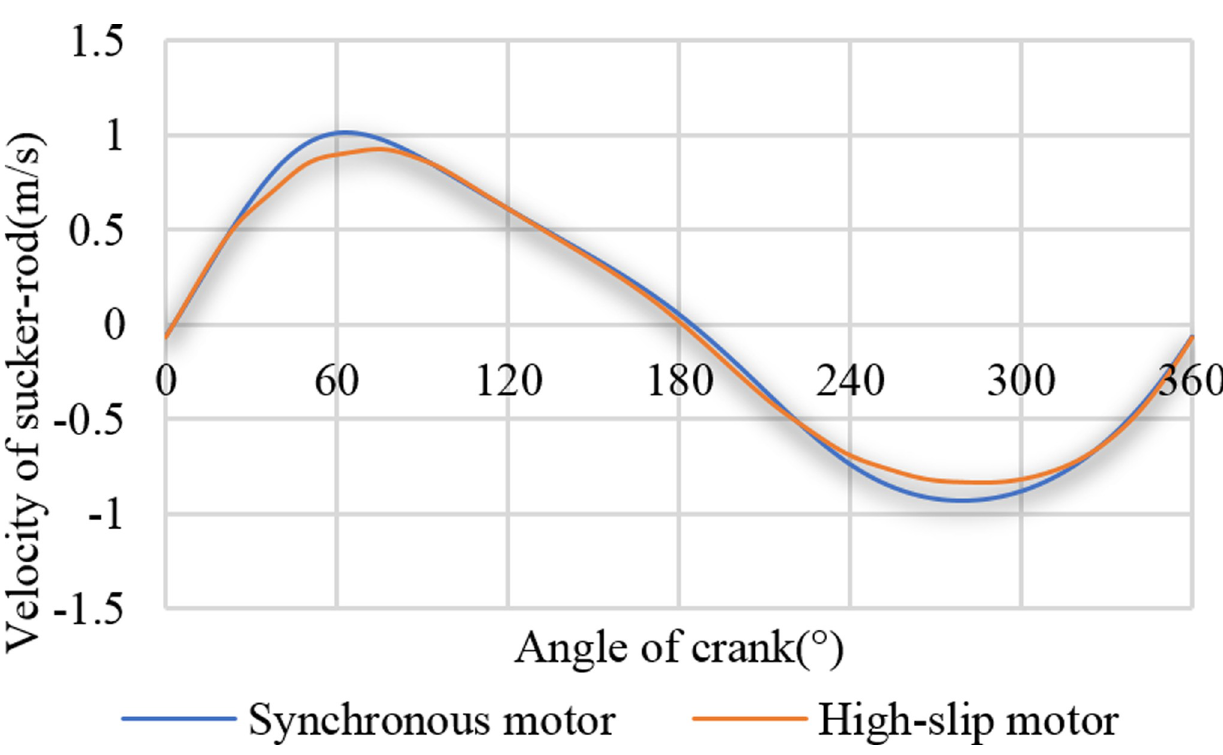
Fig 6. Velocity curves of the sucker rod.